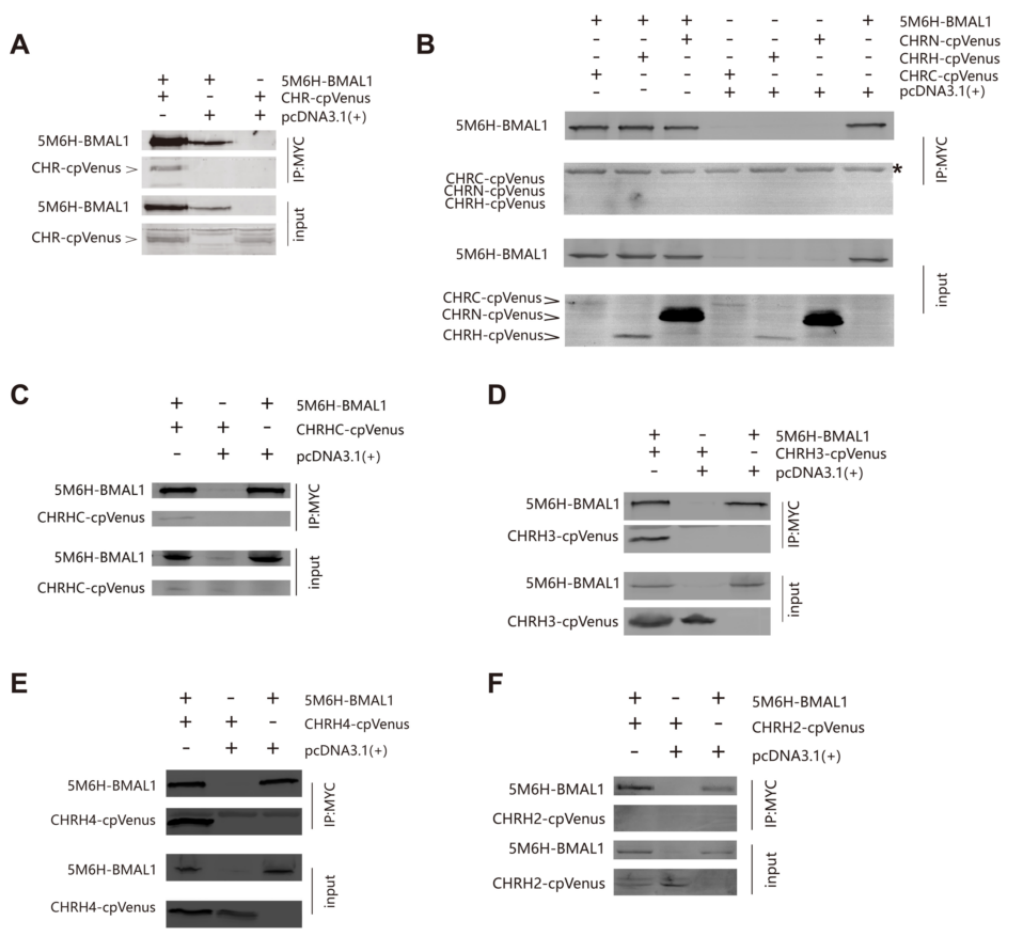
Figure 3. Co-immunoprecipitation (Co-IP) assays indicate that the helix-rich domain is necessary for CHR/BMAL1 interaction. ( A ) Full-length CHR fused with cpVenus could be immunoprecipitated by full-length BMAL1 fused with a 5Myc-6His-tag when both constructs were co-transfected in HEK 293T cells. The cellular extracts were immunoprecipitated with anti-Myc antibodies and detected by using anti-GFP antibodies. ( B ) CHRN, CHRH, and CHRC were not able to be immunoprecipitated by full-length BMAL1 when they were individually co-transfected with BMAL1 in HEK 293T cells. Consistent with the luciferase reporter assays, CHRHC. ( C ) and its shortened truncations, CHRH3